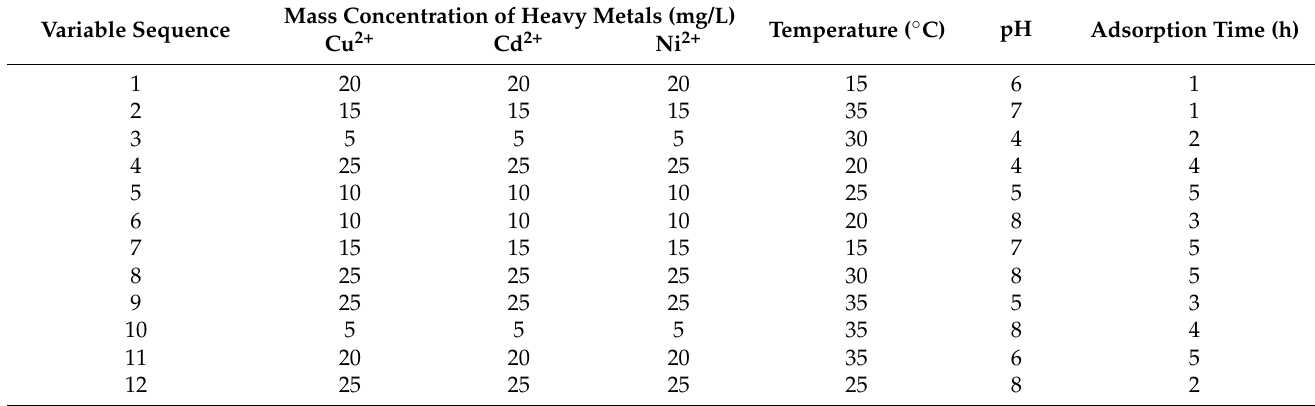
Table 1. Different algae powder adsorption experimental conditions (pH, temperature, adsorption time, initial heavy metal